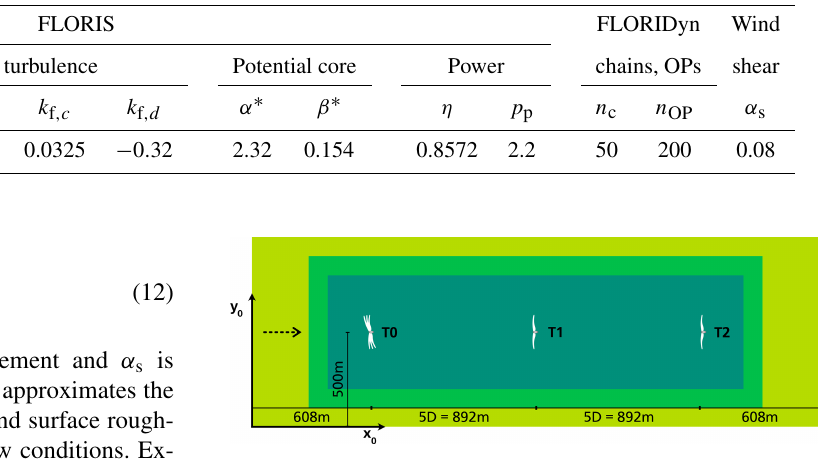
Figure 5. Scaled layout of the three-turbine case with the wind di- rection indicated by an arrow on the left. The 0, 10 and 20 ◦ yaw ori- entations from T0 are indicated as turbine symbols with the accord- ing orientation. The colored background areas indicate the zones of cell